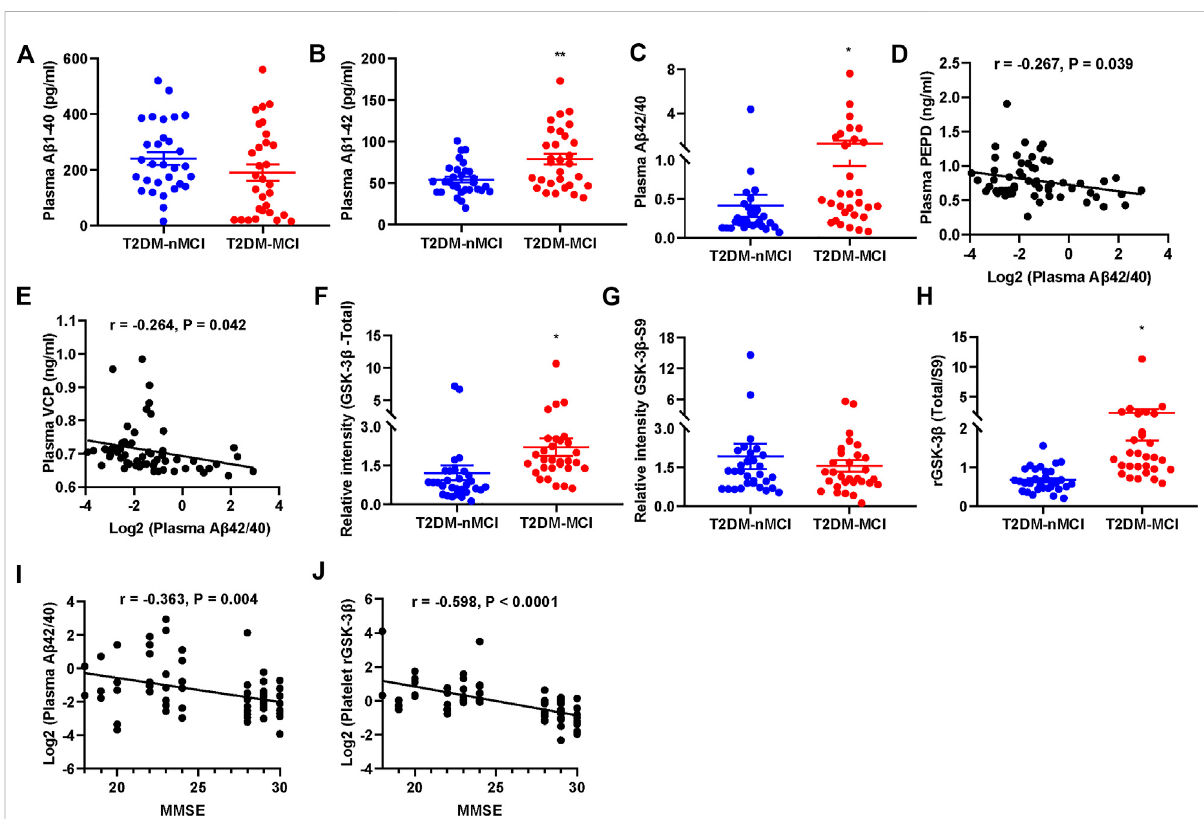
FIGURE 6 Elevated plasma A β 42/40 and platelet rGSK-3 β and their correlations with MMSE in T2DM-MCI patients. (A – C) Comparison of plasma A β 1-40, A β 1-42, andA β 42/40 inT2DM-MCI vs. T2DM-nMCI. (D,E) Correlation ofthePEPDorVCPlevel withtheA β 42/40 ratio. (F – H) Comparison